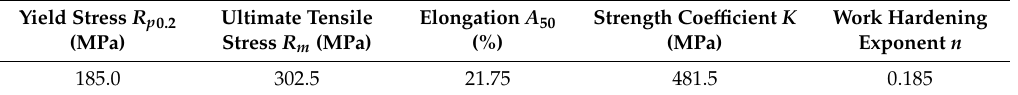
Table 2. Selected mechanical properties of DC04 steel